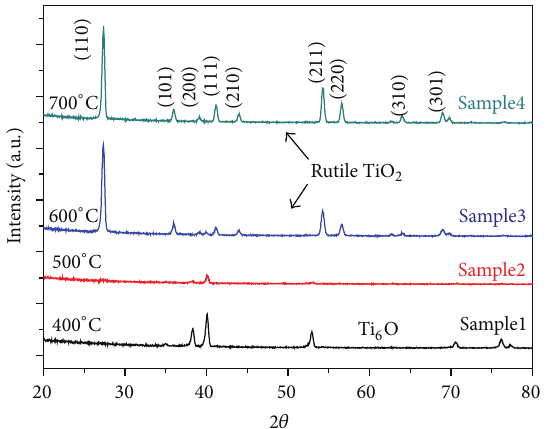
Figure 2: XRD patterns of TiO 2 , which are annealed at different temperatures.